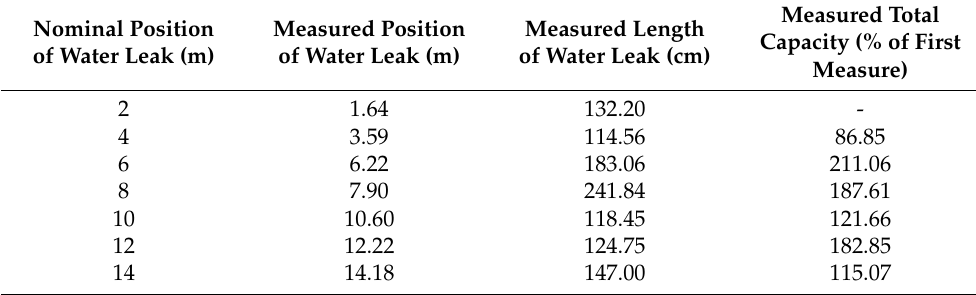
Table 2. Estimation results for the water leak position and entity estimation in the case of leak length 2 m. Nominal